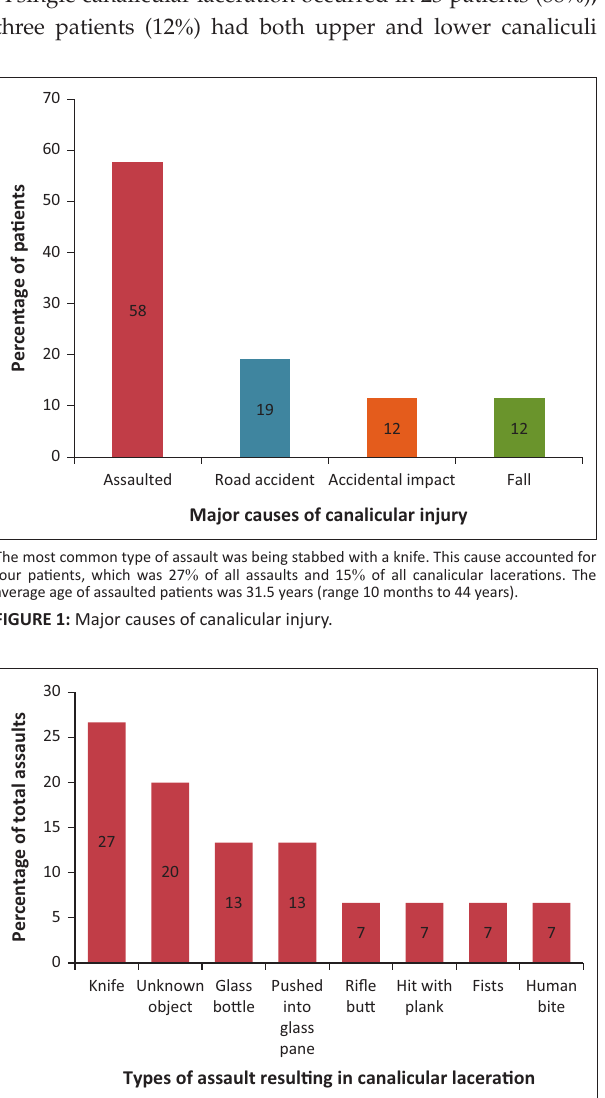
FIGURE 2: Types of assault resulting in canalicular